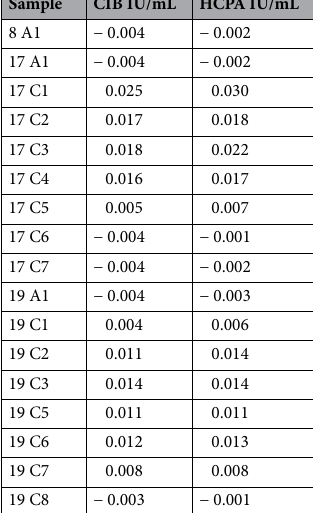
Table 2. Comparative results of Escherichia coli -derived ASNase activity (IU/mL) between Centro Infantil Boldrini (CIB, Campinas, Brazil) and Hospital de Clínicas de Porto Alegre (HCPA, Porto Alegre, Brazil). CIB Centro Infantil Boldrini (Brazil), IU International units; Intraclass correlation coefficient =